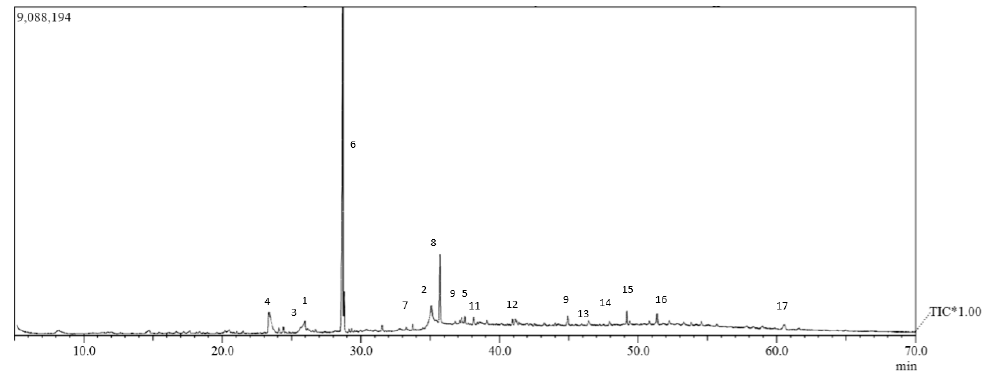
Figure 1. Growth curve of G1 callus